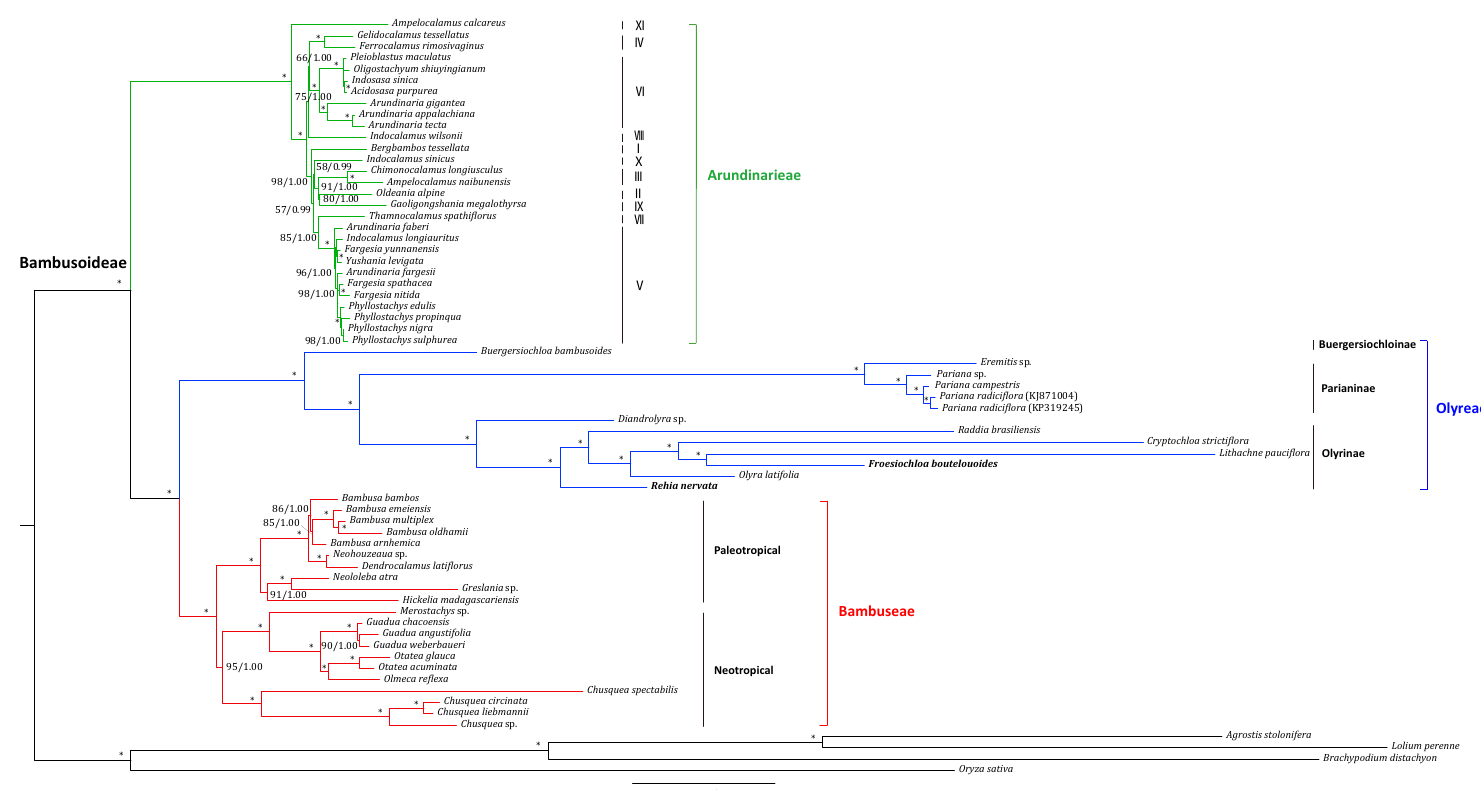
Figure 6. Congruent maximum likelihood (ML) and majority-rule consensus Bayesian inference (BI) tree for Bambusoideae based on the complete plastome sequences of 67 grasses. Values above the branches represent maximum likelihood bootstrap (MLBS)/Bayesian inference posterior probability (PP). * indicates nodes with 100/1.00 support values. The positions of newly sequenced herbaceous bamboos ( Froesiochloa boutelouoides and Rehia nervata ) were shown in